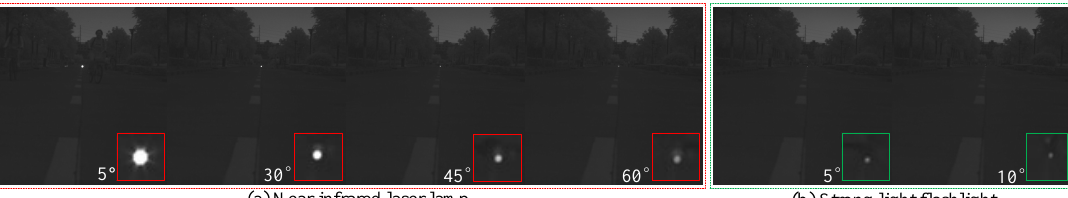
Figure 6. The comparison of the imaging from different angles at the distance of 150 m. ( a ) The near infrared laser lamp: from 0 degrees to 45 degrees; ( b ) The strong light flashlight: from 0 degrees to 10